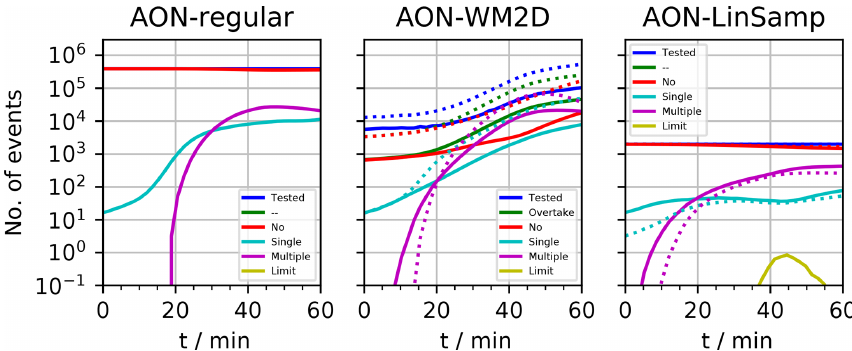
Figure 8. BoxModelEmul set-up: time series of a number of events in the various AON versions. Shown are the number of tested SIP combinations, of overtakes, of no collection, of a single collection and of a multiple collection in every time step. Additionally, the number of limiter cases, where ν coll had to be artificially reduced, is shown (occurs only in the LinSamp panel). The parameter set-up is given in the text. In the WM2D panel, the dotted lines show the case with (cid:49)z = 10m. In the LinSamp panel, the dotted lines show the 1s simulation. The displayed numbers can be below unity, as averages over 20 instances are shown.